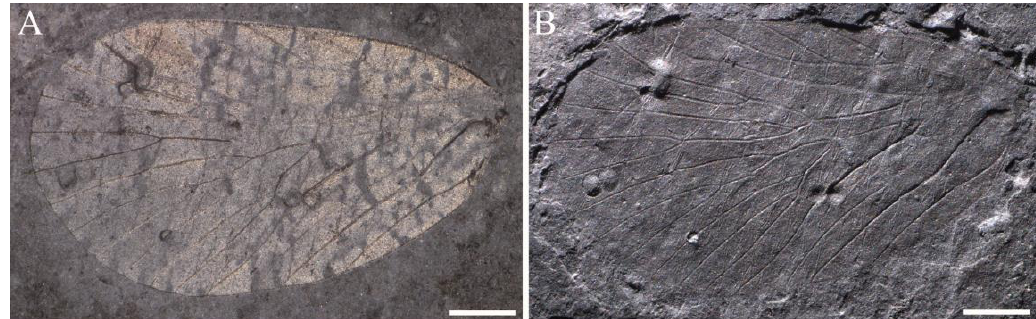
(Figure 5 and Figure 19C; ZooBank LSID urn:lsid:zoobank.org:act:9E2C0D32-5E2C-